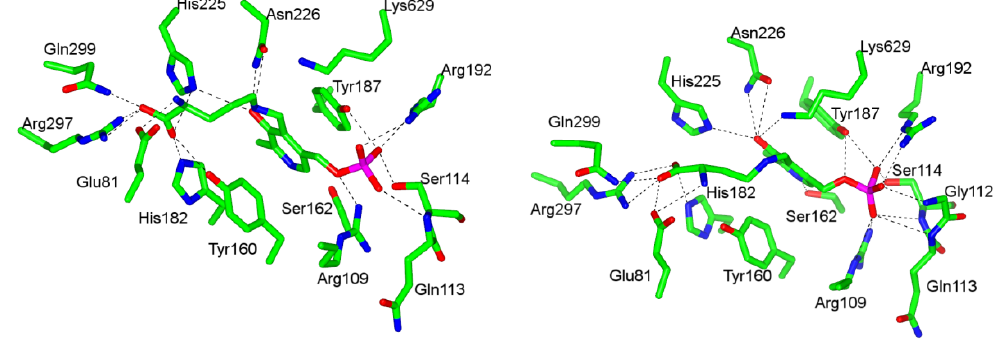
Figure 3. Binding sites of ( left ) PLP-ornithine adduct (PDB accession code: 3KOZ) and ( right ) PLP-DAB adduct (PDB accession code: 3KOX) in 4,5-OAM. These figures were generated using CCP4MG Version